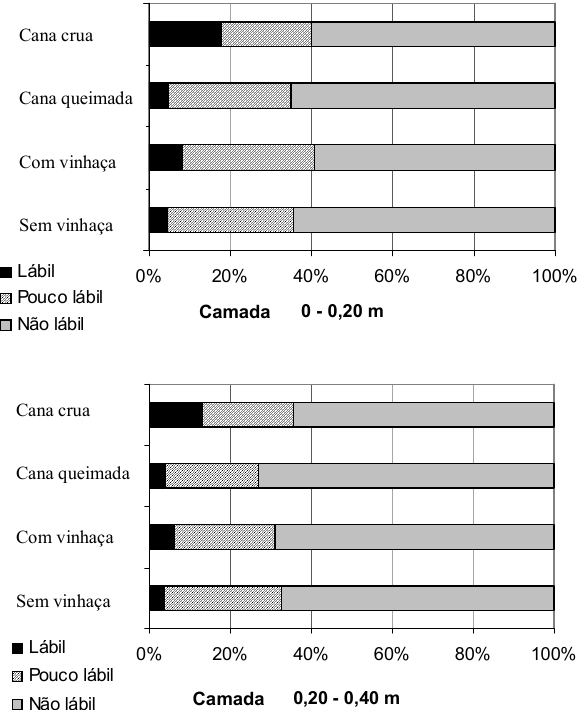
Figura 3. Distribuição relativa das formas de P lábil, pouco lábil e não-lábil em relação ao P recuperado por meio de extração seqüencial em um Cambissolo Háplico Ta eutrófico vértico da região Norte Fluminense submetido ao cultivo de cana-de-açúcar por longo